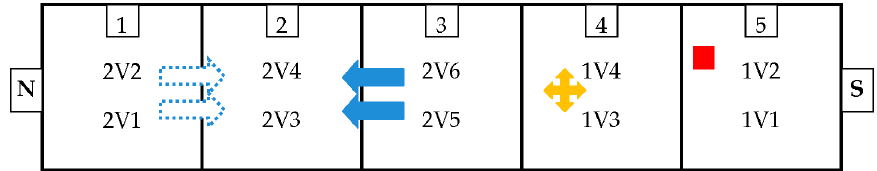
Figure 6. Operation pattern of fans with the operating status of devices during the test (red square—fire, yellow cross—visibility detector, filled arrows—actual fans operation, dotted arrows—expected fans operation).